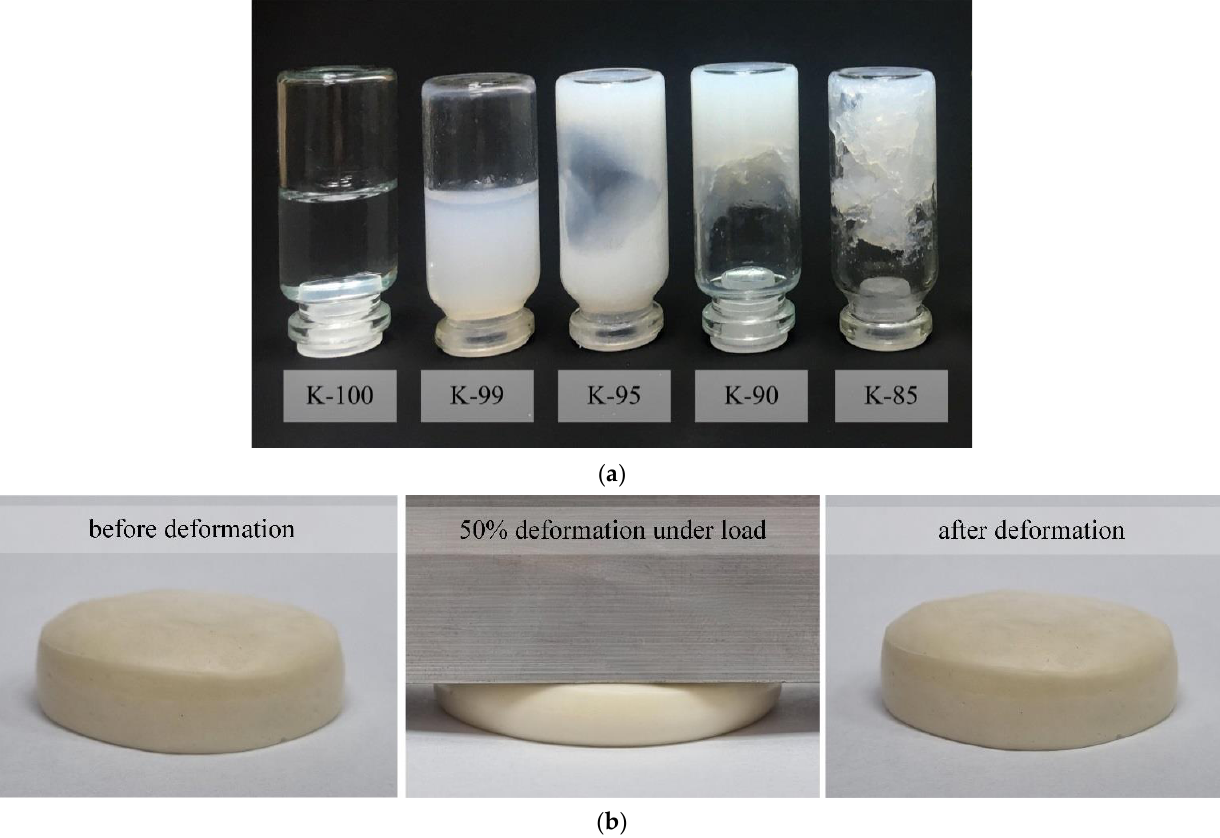
Figure 1. Appearance of gel fuels: ( a ) Liquid and plastically deformable fuel compositions based on kerosene: K-100 — 100 % kerosene, K-99 — 99 wt% kerosene, 1 wt% silicon dioxide, K-95 — 95 wt% kerosene, 5 wt% silicon dioxide, K-90 — 90 wt% kerosene, 10 wt% silicon dioxide, K-85 — 85 wt% kerosene, 15 wt% silicon dioxide; ( b ) Elastically deformable: 50 vol% oil + 48 vol% aqueous solution of PVA (10 wt%) + 2 vol%